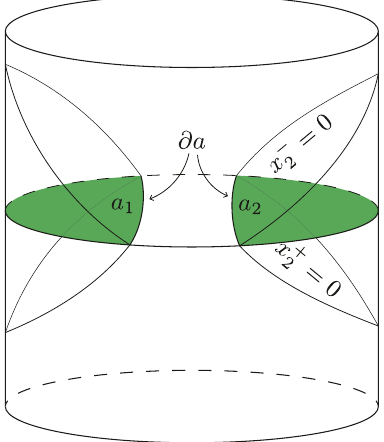
Figure 2 . Region a = a 1 ∪ a 2 is shown in orange. Each D ( a r ) is an AdS-Rindler wedge whose future and past boundary lies on a Killing horizon. For D ( a and x + = 0 2